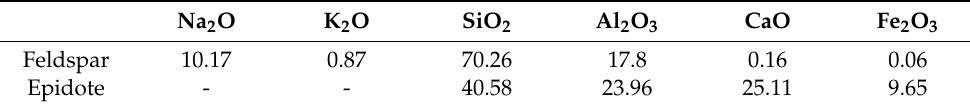
Table 1. Chemical Compositions of the Purified Samples (%).